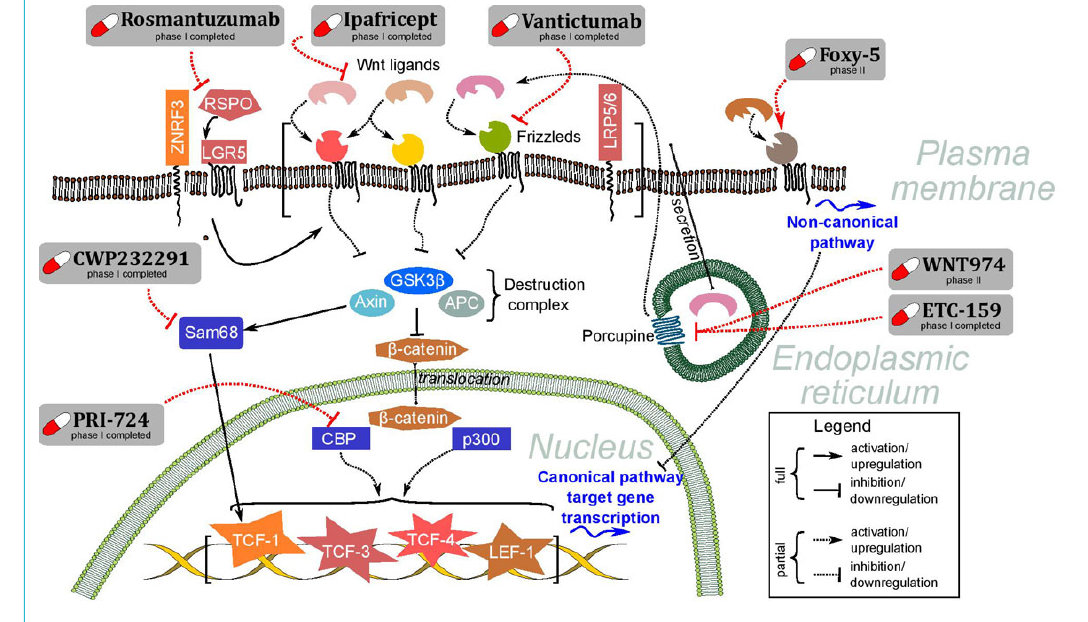
Figure 1: Drug compounds of past or current clinical trials target the Wnt pathway at the ligand/receptor level (rosmantuzumab, ipafricept, vantictumab and Foxy-5) or at the transcriptional level (CWP232291 and PRI-724). Porcupine inhibitors (WNT974 and ETC-159) target Wnt